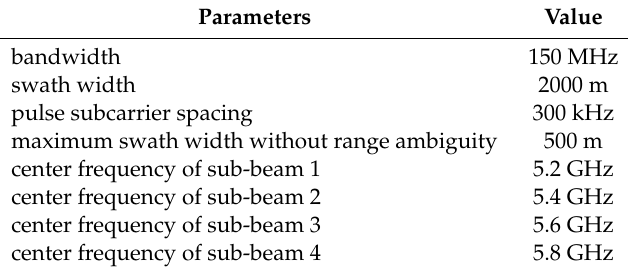
Table 3. Parameters Used in Figure